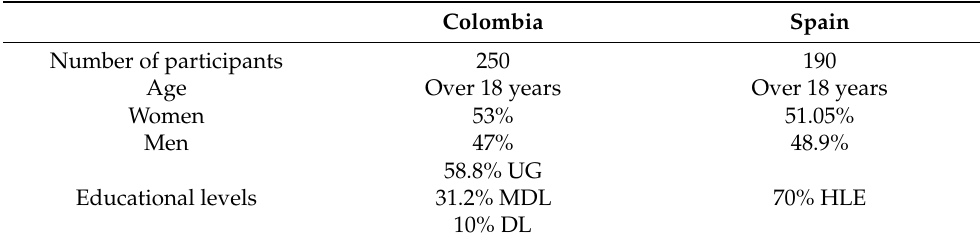
Table 1. Characteristics of